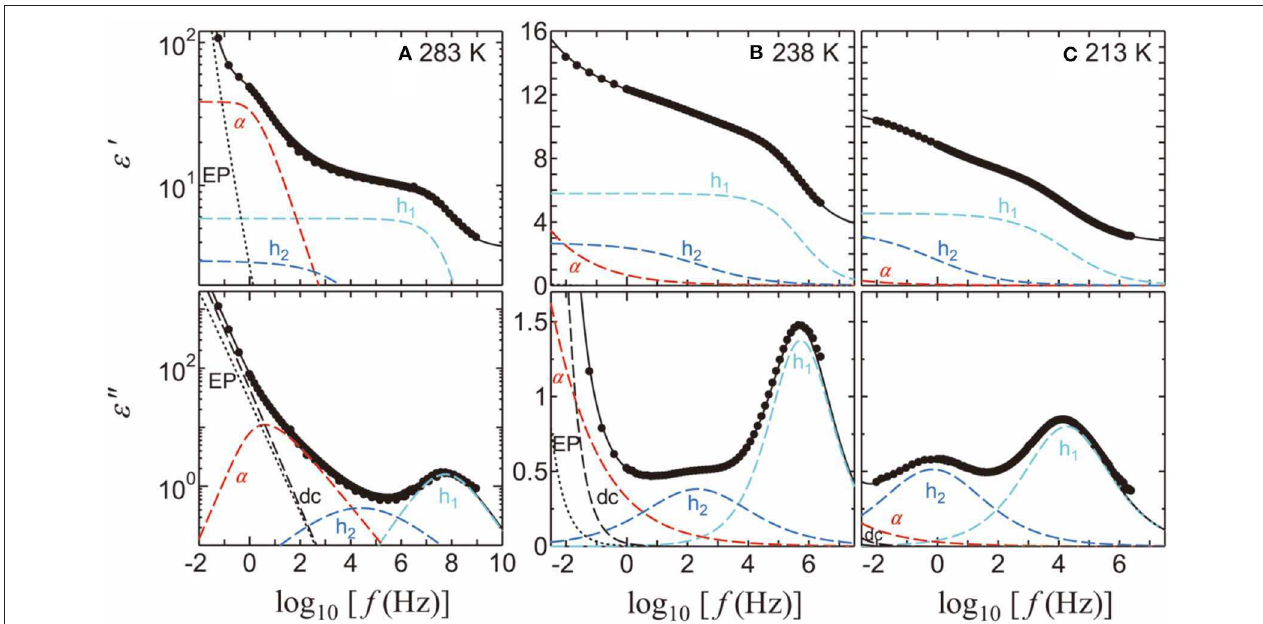
FIGURE 4 | The fitting results and spectra for the 65 wt% PVP–PG mixture at (A) 283, (B) 238, and (C) 213K. The solid black curves indicate the fitting results. The light-blue, blue, and red dashed curves indicate the h 1 , h 2 , and α -processes, respectively. The black dashed and dotted curves indicate dc conductivity and EP,